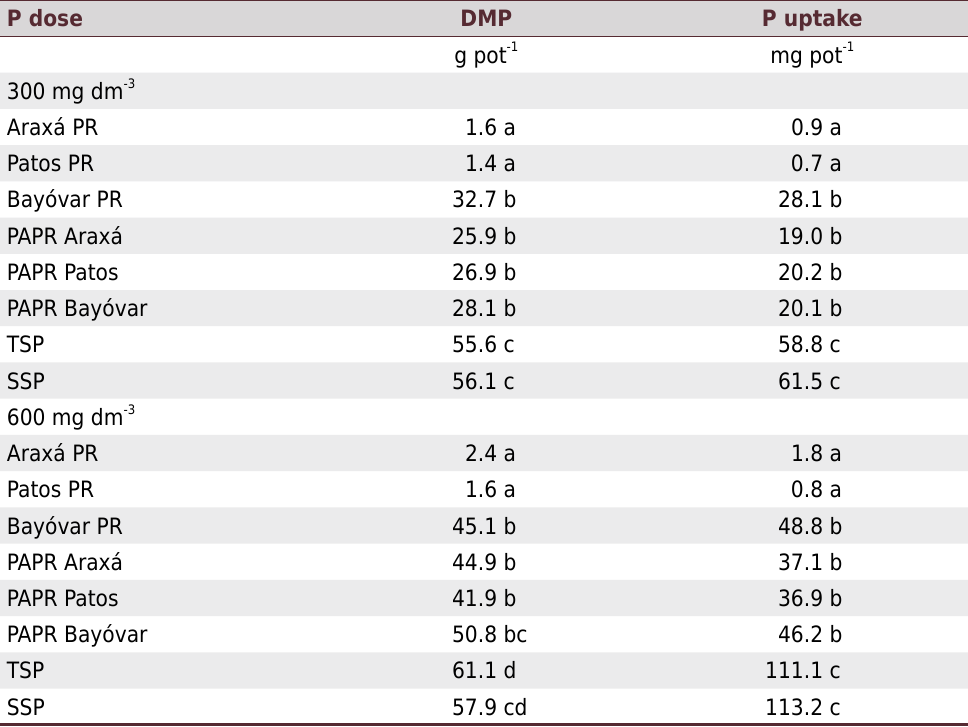
Table 2. Effects of P fertilizers of different solubilities and P doses on dry matter production and P uptake by corn P dose DMP